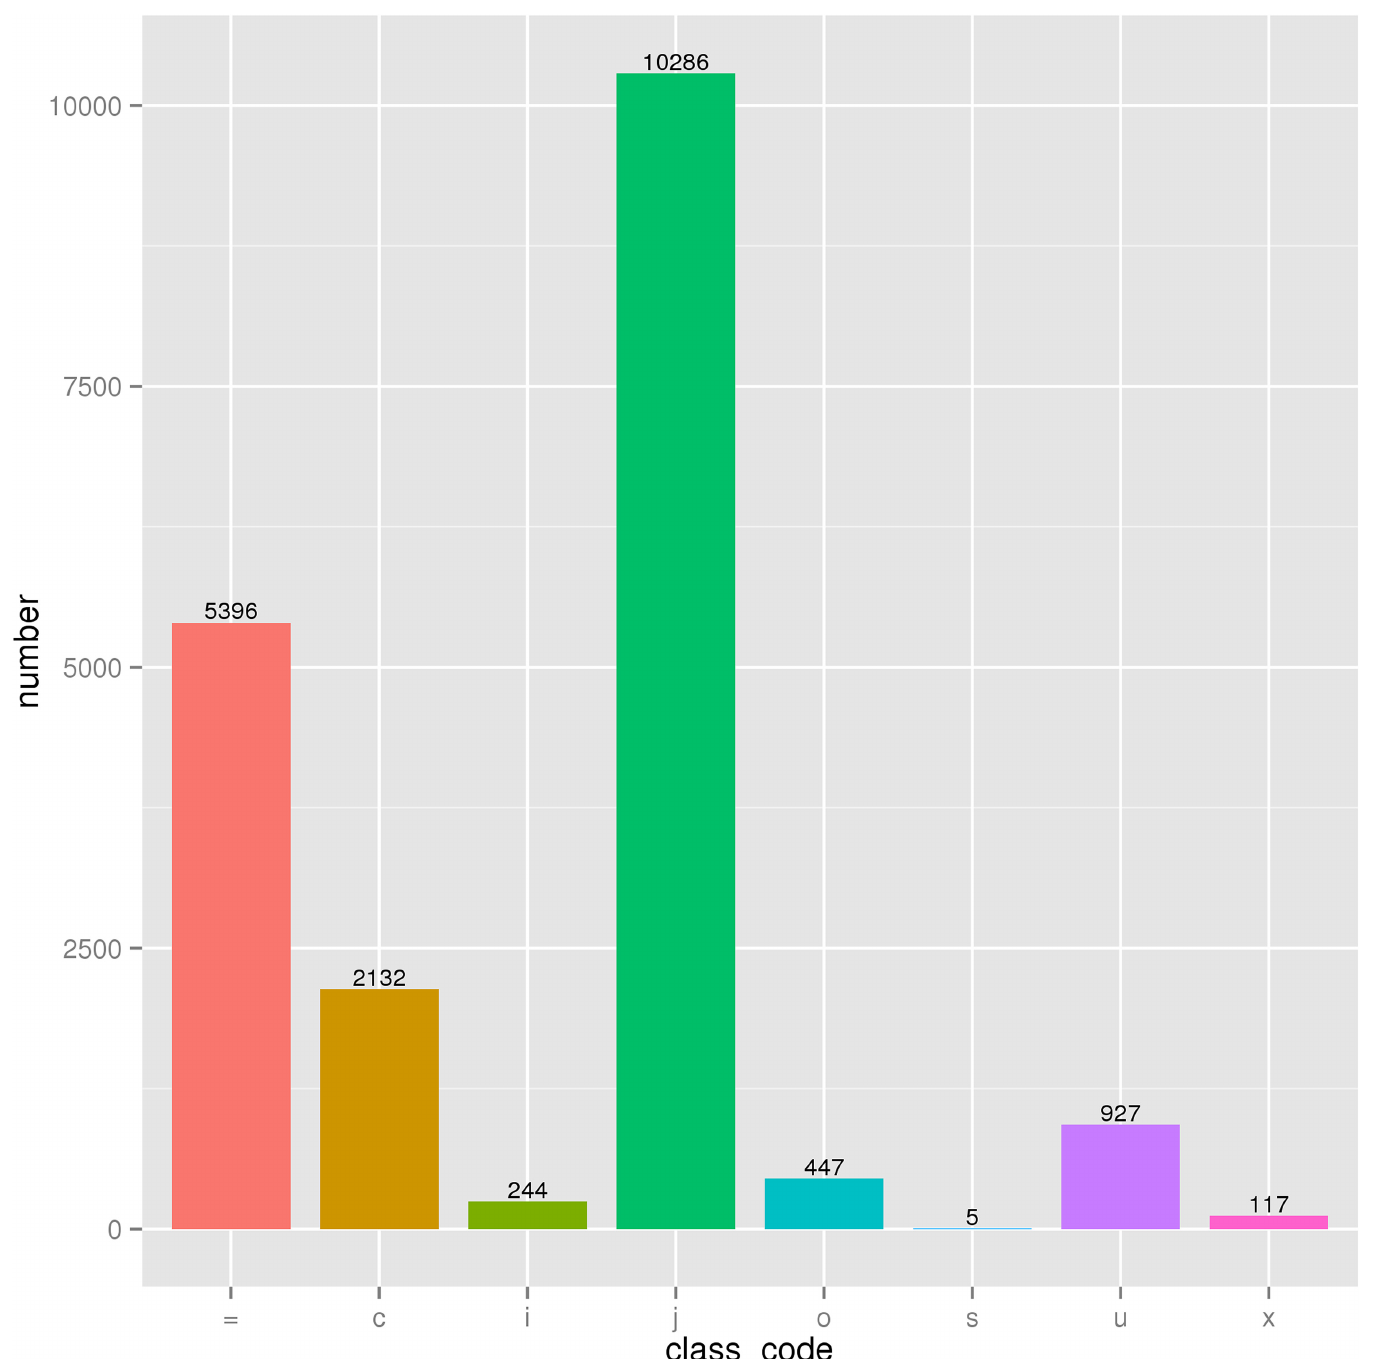
Fig 2. Distribution of sheep skin transcripts by Cufflinks class code. =, Complete match of intron chain; c, Contained by a reference transcript;I, A transfrag falling entirely within a reference intron; j, At least one splice junction is shared with a reference transcript; o, Generic exonic overlap with a reference transcript; s, An intron of the transfrag overlaps a reference intron on the opposite strand; u, Unknown, intergenic transcript; x, Exonic overlap with reference on the opposite strand.